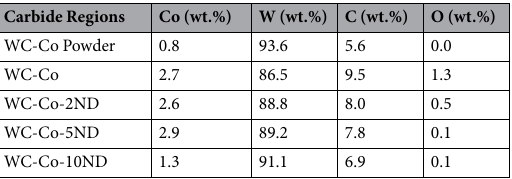
Carbide Regions Co (wt.%) W (wt.%) C (wt.%) O (wt.%)